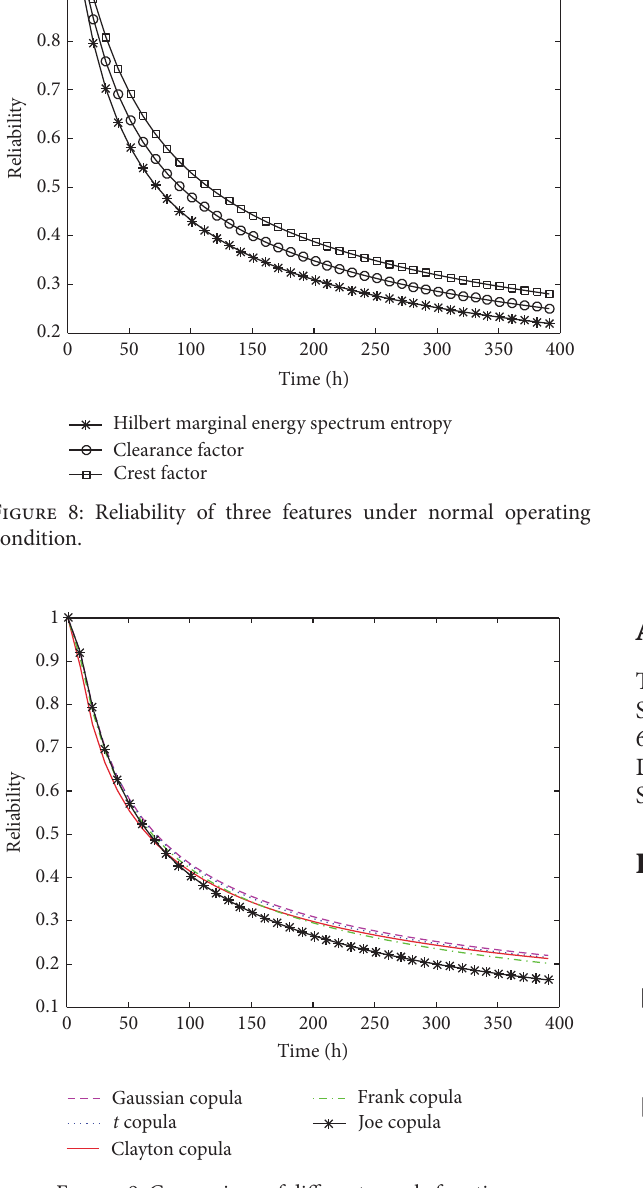
Figure 9: Comparison of different copula functions.